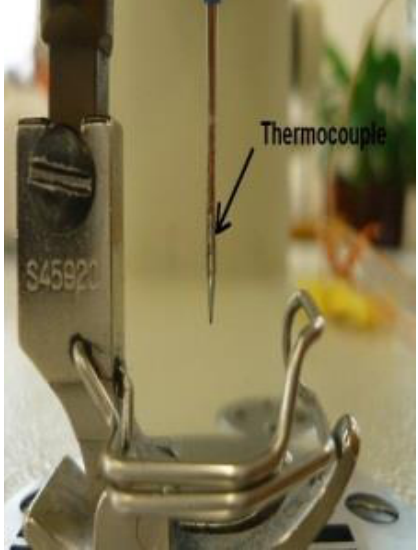
Figure 2. Thermocouple embedded in the needle. Subsequently, to measure the strength of the threads, the sewing thread was taken out of the seam and the tensile strength of the final thread, after stitching, was compared with its parent strength. The thread was pulled out of the seam by carefully cutting the bobbin thread, without disturbing the